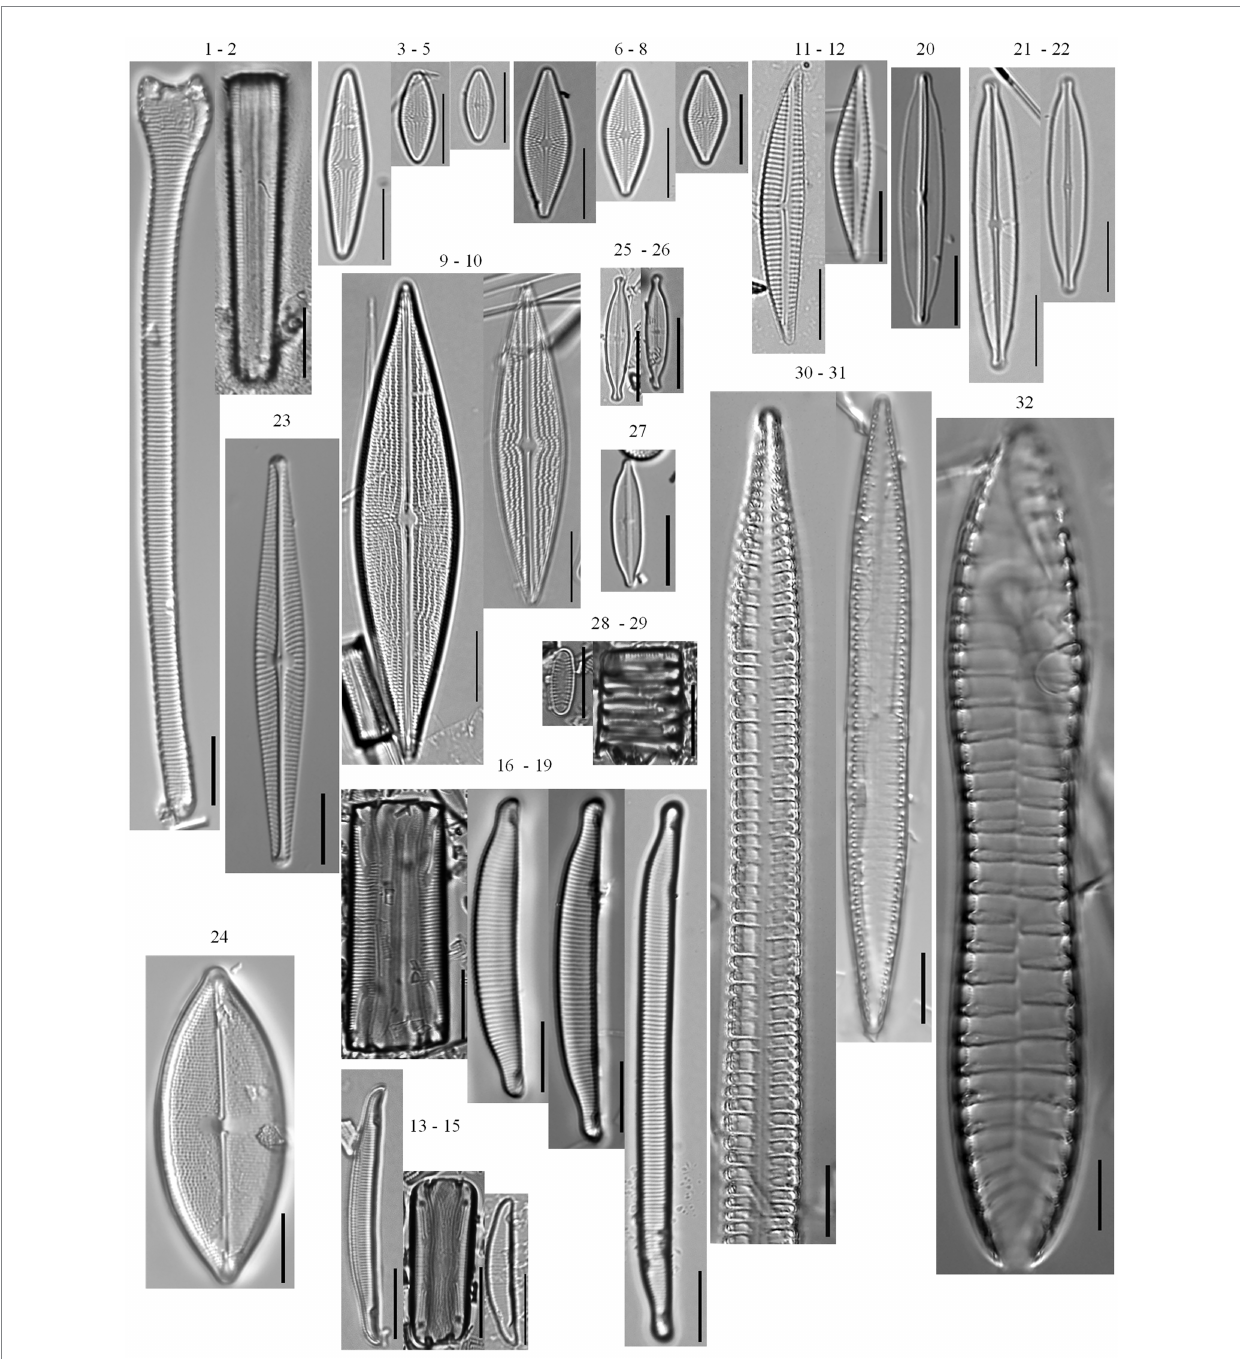
FIGURE 4 Tychoplanktonic diatom taxa found in the phytoplankton net monthly sampling (2005–2019) and the 166 cm sediment core. Actinella punctata (1–2), Brachysira brebissonii (3–5), Brachysira gravida (6–8), Brachysira serians (9–10), Encyonema neogracile (11–12), Eunotia incisa (13–15), Eunotia veneris (16–19), Frustulia pseudomagaliesmontana (20), Kobayasiella mesp03 (21–22), Navicula leptostriata (23), Neidium pseudodensestriatum (24), Nupela neotropica (25–26), Nupela rumrichorum (27), Oxyneis binalis var. elliptica (28–29), Surirella cuspidata (30– 31), Surirella grunowii